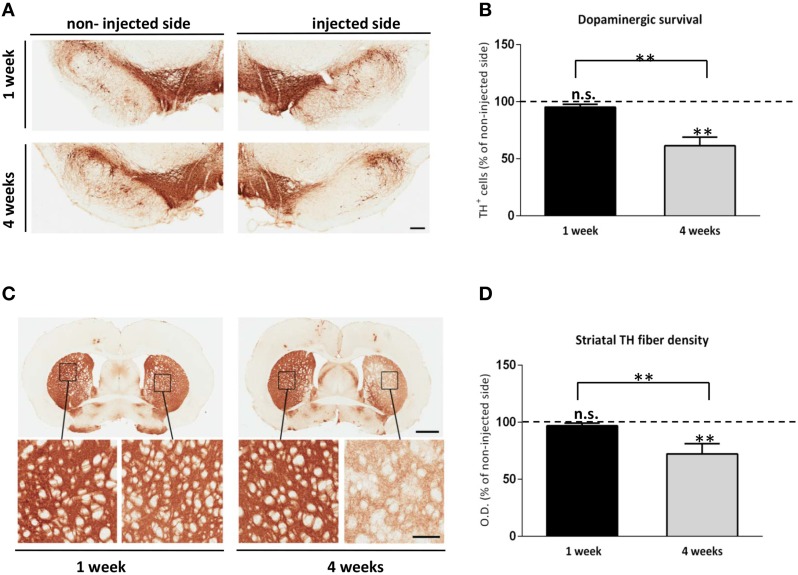
Alpha synuclein associated neurotoxicity in the SL1SL2 rat model. (A) Representative TH immunohistochemical staining of nigral sections in animals injected with AAV8-SL1SL2 at 1 and 4 weeks. Scale bar represents 250 μm. (B) illustrates in a graph bar the estimation of total TH+ cells in the SN (expressed as % of non-injected side) using unbiased stereological counting at 1 and 4 weeks. 38.5 ± 7.5% significant dopaminergic cell loss was found at 4 weeks when compared to the non-injected side [Paired Students' T-test, T(9)= 5.0, **p < 0.001] and One-way ANOVA analysis followed by a Tuckey's for multiple testing revealed a 33.81 ± 7.9% significant difference between 1 and 4 weeks (**p < 0.001). (C) Photomicrographs illustrating TH+ terminals in the STR in SL1SL2 animals. Scale bars represent 2 mm and 300 μm (zoomed-in pictures). (D) Illustrates in a bar graph the quantitative densitometry of the TH+ fibers measurements (expressed as percentage of non-injected side). The bars represent the average of four different rostro caudal levels of the STR measured for each animal. Statistical difference was found at 4 weeks in the injected side compared to the non-injected side [Paired Students' T-test, T(9) = 5.0, **p < 0.001] and also between time point group (**p < 0.001). n = 6, for 1 week group and n = 8, for 4 weeks group.